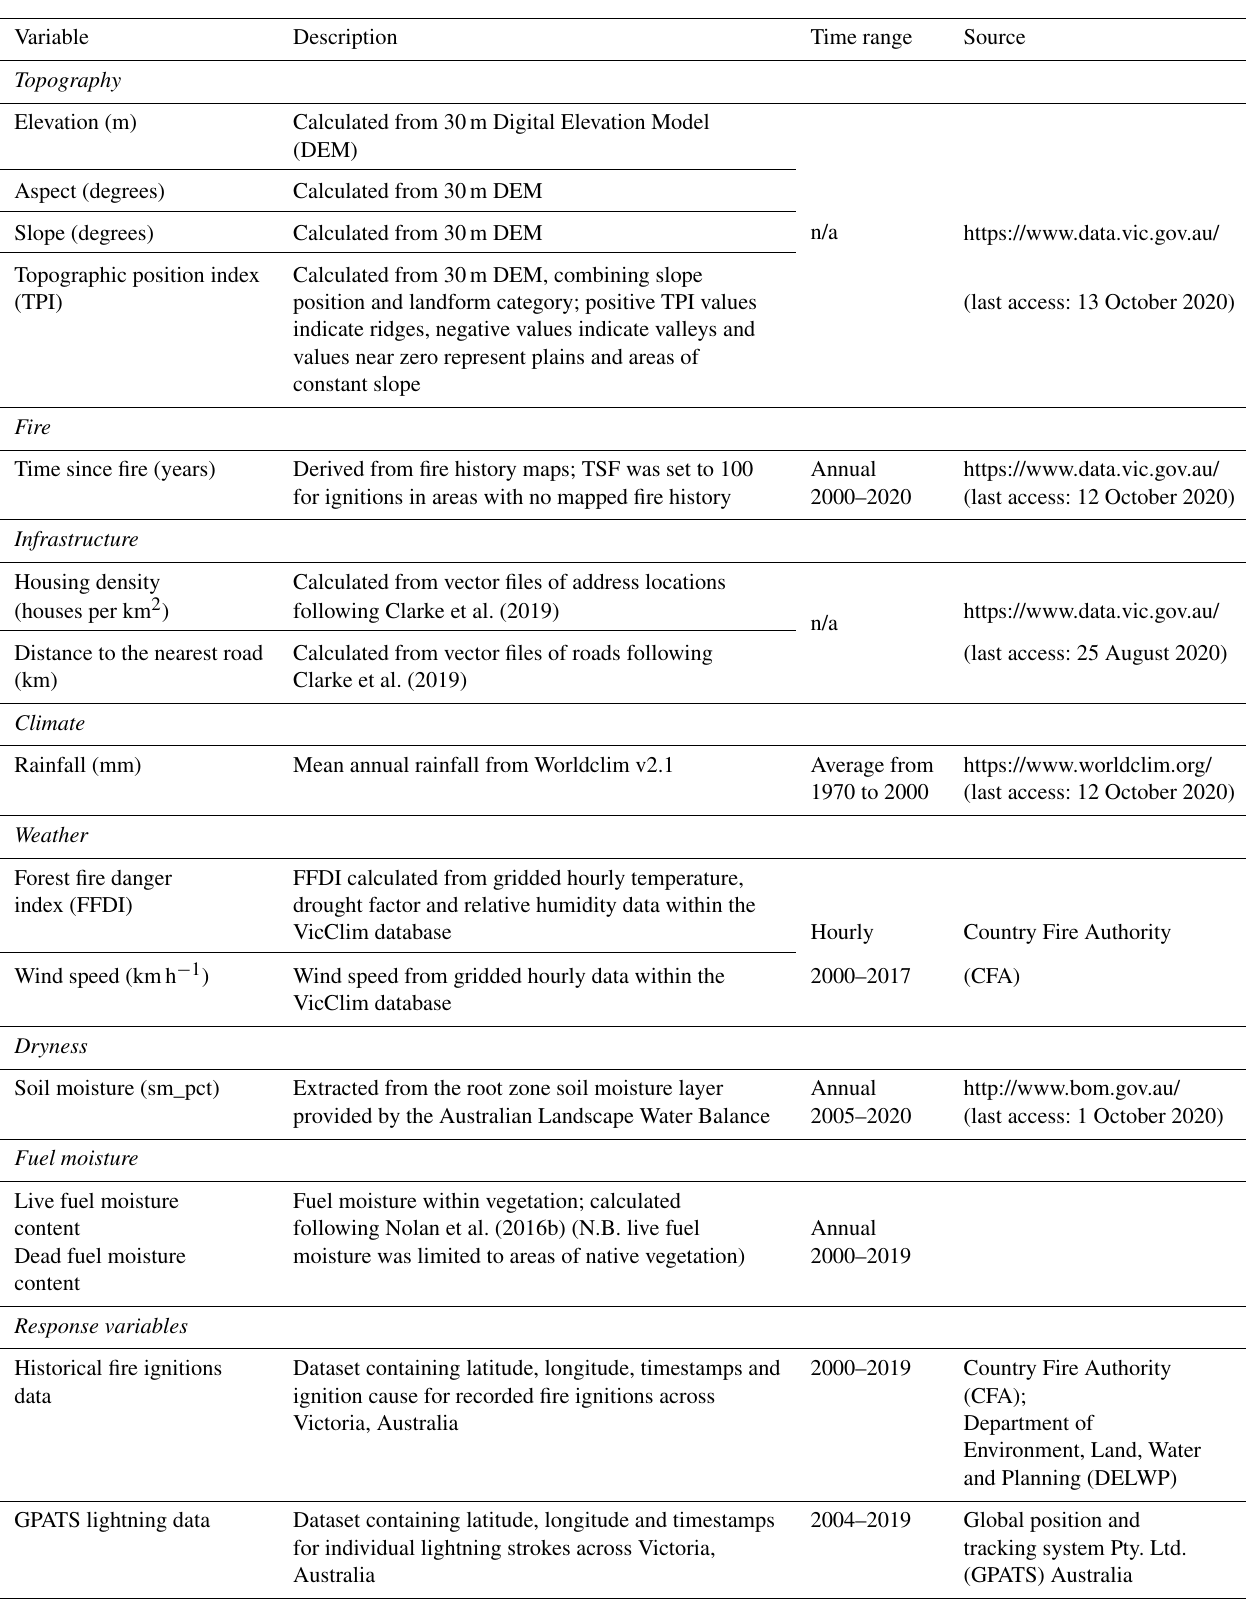
Table 1. Environmental and human-mediated variables used as predictors in model development. The table provides a description of the variable and the source of the